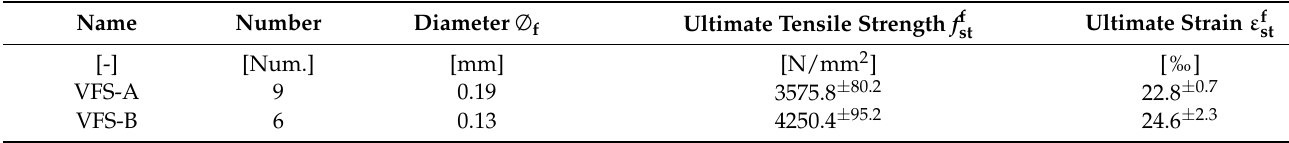
Table 1. Mechanical properties of steel fibres under monotonic tensile loading.